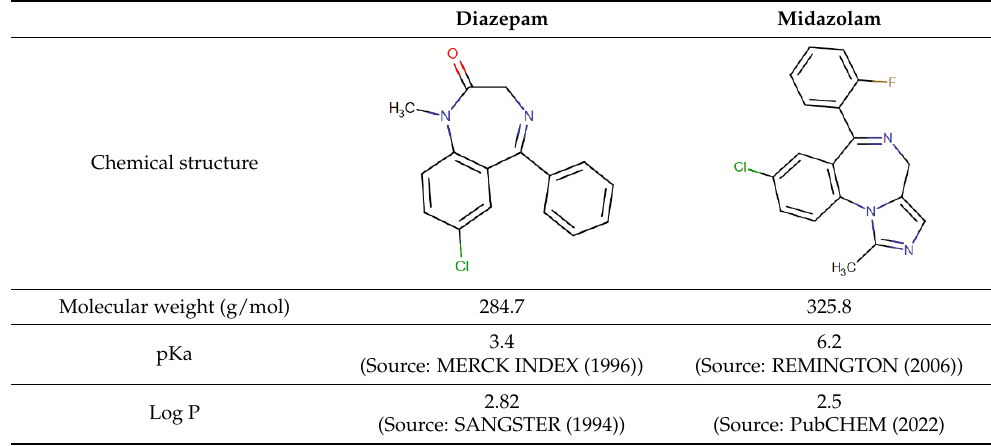
Table 1. Physicochemical characteristics of diazepam and midazolam.